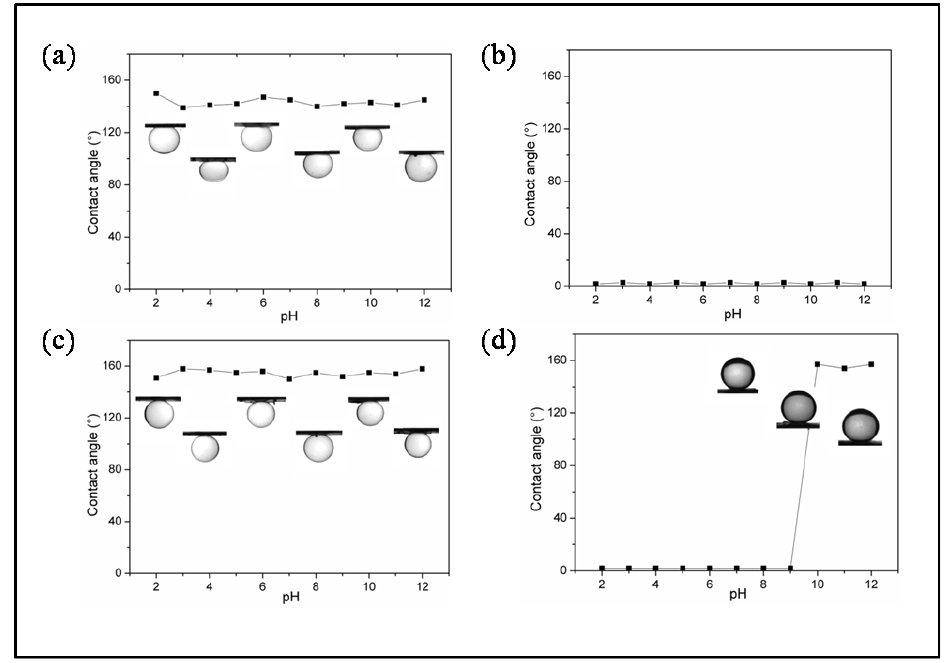
Figure 6. Contact angles (CA) of the oil droplets on the membrane as a function of the pH value in the aqueous phase: ( a ) hexane and ( b ) 1, 2-dichloroethane on PVDF-F127 membrane surface, respectively; ( c ) hexane and ( d ) 1, 2-dichloroethane on PVDF-F127-P (MMA-AA) membrane surface, respectively.